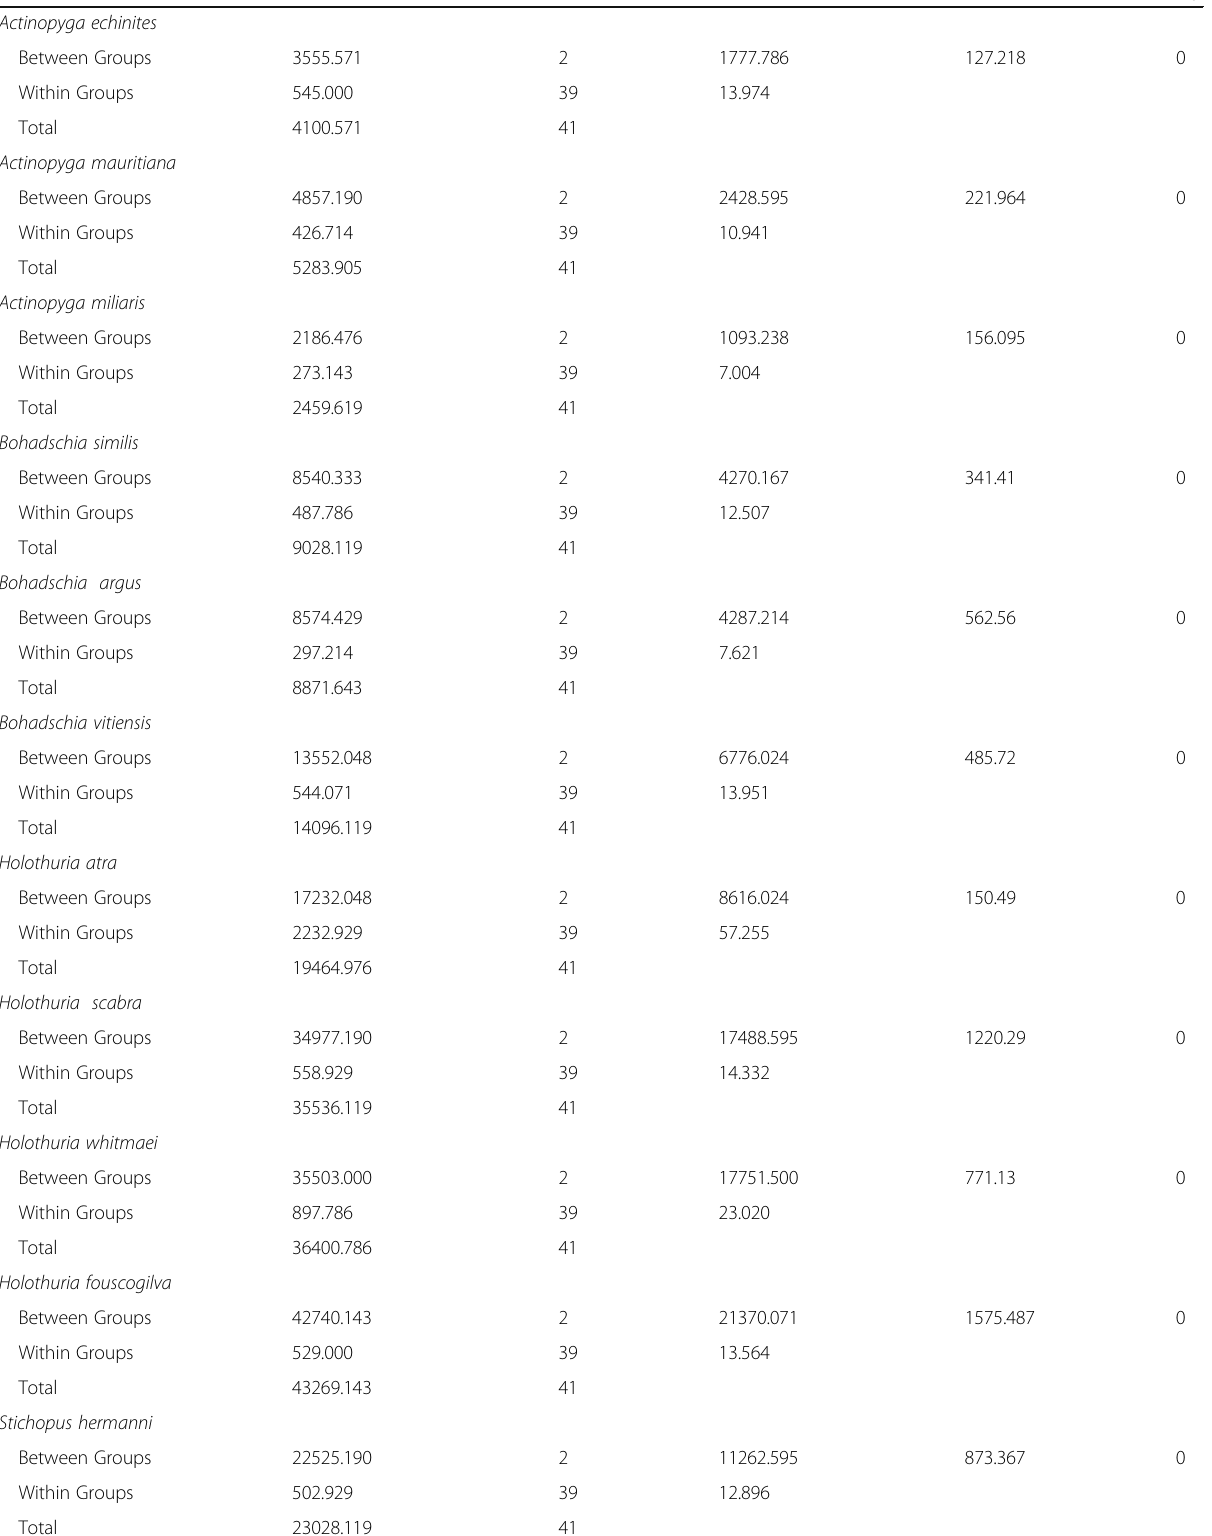
Table 7 The analysis of one way ANOVA for different species during the period of study (2000, 2006 and 2016) Sum of Squares df Mean Square F